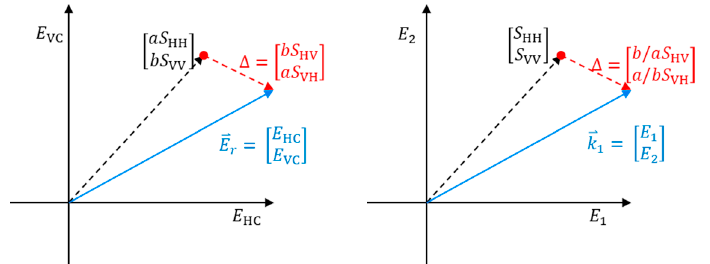
(cid:42) (cid:42) 𝑘(cid:4652)⃑ 𝐸(cid:4652)⃑ (cid:3045) and (cid:2869) . E r and k 1 . Figure 1. Schematic representation of